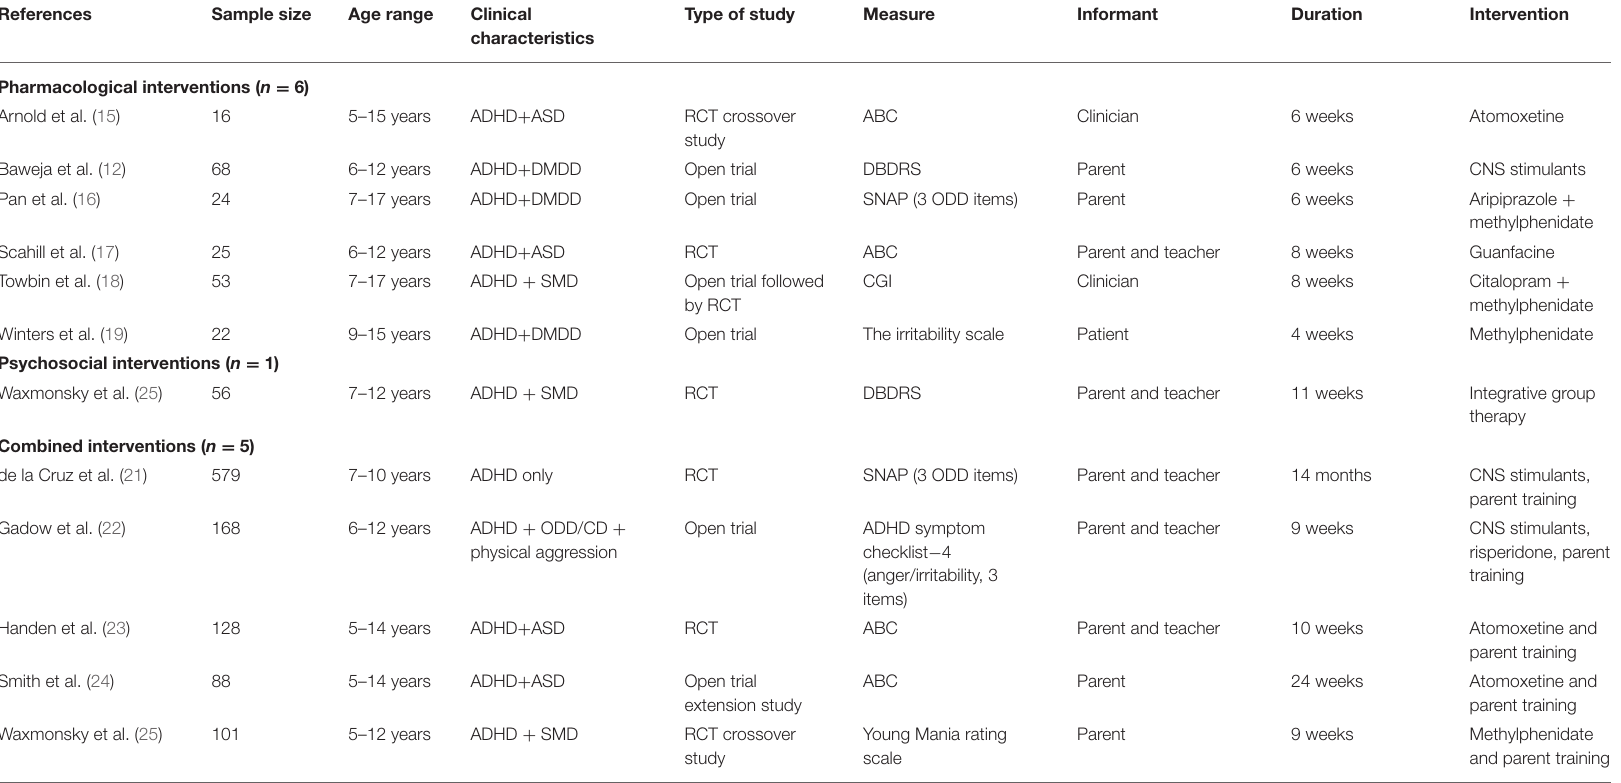
TABLE 1 | Articles targeting irritability in youth with ADHD included in the mini review ( N =